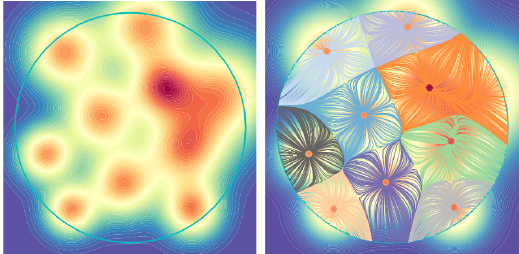
Figure 1: Illustration of basins of attraction. Left: Ex- ample of a of 2 d energy landscape. High-energy points are shown in blue, low-energy points in red. Right: In the same landscape, trajectories of steepest descent and ascent ˙ x = ± ∇ U ( x ) are spawned from random points, and confined to an arbitrary region (blue circle). Tra- jectories converging to the same minimum belong to the same basin of attraction and are plotted in the same